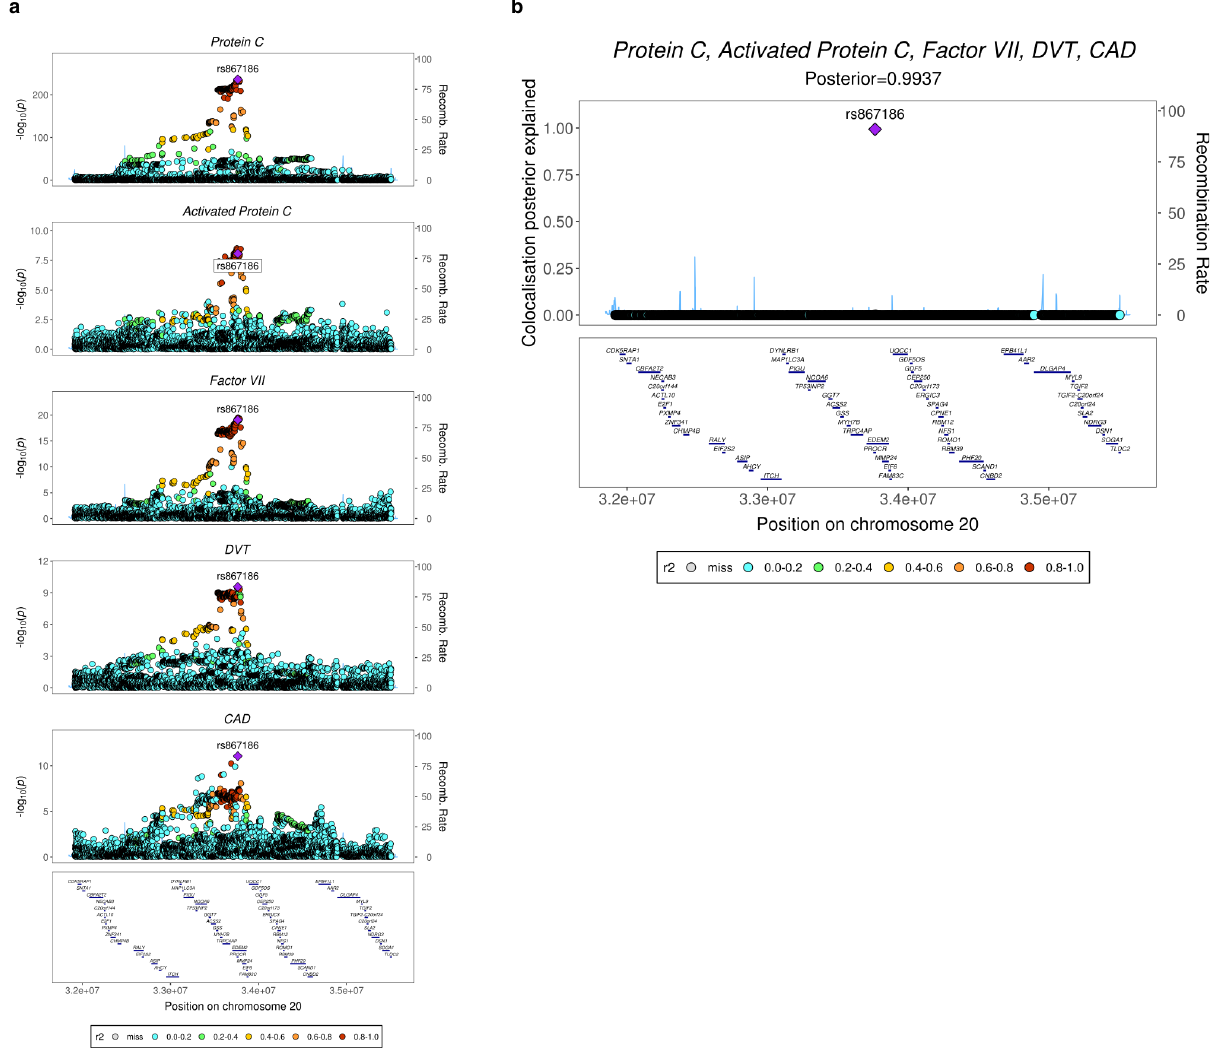
Fig. 3 Statistical colocalization of cardiovascular outcomes and traits at the PROCR locus. a Regional association plots at the PROCR gene locus, showing the genetic association with coagulation factor VII, protein C, activated protein C, DVT and CAD. Unadjusted P values were obtained from the published GWAS. Details about the statistical analysis and source of the data are given in the Methods section. Color key indicates r 2 with the respective lead variants in the GWAS. b Plot showing the colocalization posterior probabilities explained by each of the genetic variants at the chr20q11.22 locus tested in the